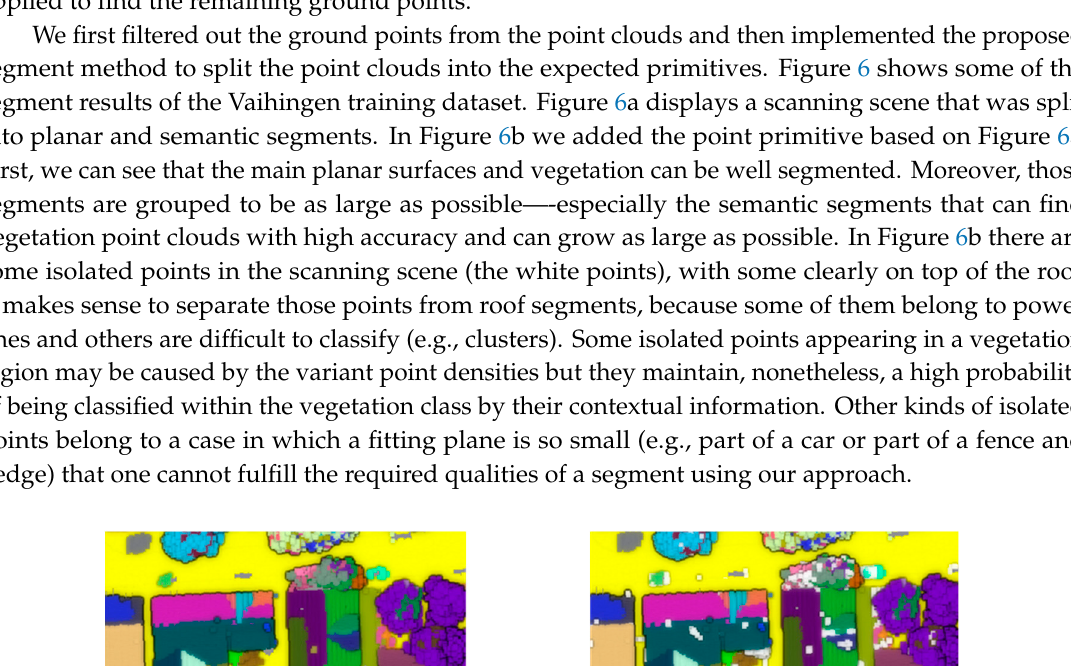
Figure 7. 3D View of the semantic labeling results for the three Vaihingen areas with five classes: ground (orange), building roof (blue), vegetation (green), façade (yellow), and other (red). ( a ) vs. Area 1, ( b ) vs. Area 2, and ( c ) vs. Area (3). Figure 7 shows the semantic labeling results for the three Vaihingen study areas. 3D points were labeled with predefined classes: ground (orange), building roof (blue), vegetation (green), façade (yellow), and other (red). First, in line with the main purpose of classification using our method, building structures satisfying the predefinition of a building area larger than 50 m 2 in our tests can be safely and effectively detected and extracted, with point clouds of reasonable quality. The minute planes were properly assigned to the other group, because they neither satisfied the area threshold of a building roof (15 m 2 ) nor resonated with the discriminative features of other classes. The façade of a building could be reasonably detected by the proposed method in such areas. From Figure 7 we can see that, although there are some mistakes in the vegetation class, the main vegetation areas (>5 m 2 ) can be detected and extracted reasonably well. The fault classification of vegetation is mainly in the case of the fence and hedge. Because some low vegetation twines on those objects, and we did not predefine a certain class for the fence and hedge, some parts of the objects will be divided into vegetation and others into other . Some small objects (e.g., cars) were also incorrectly assigned to the vegetation class. One reasonable explanation is that the structures of those objects are extremely small